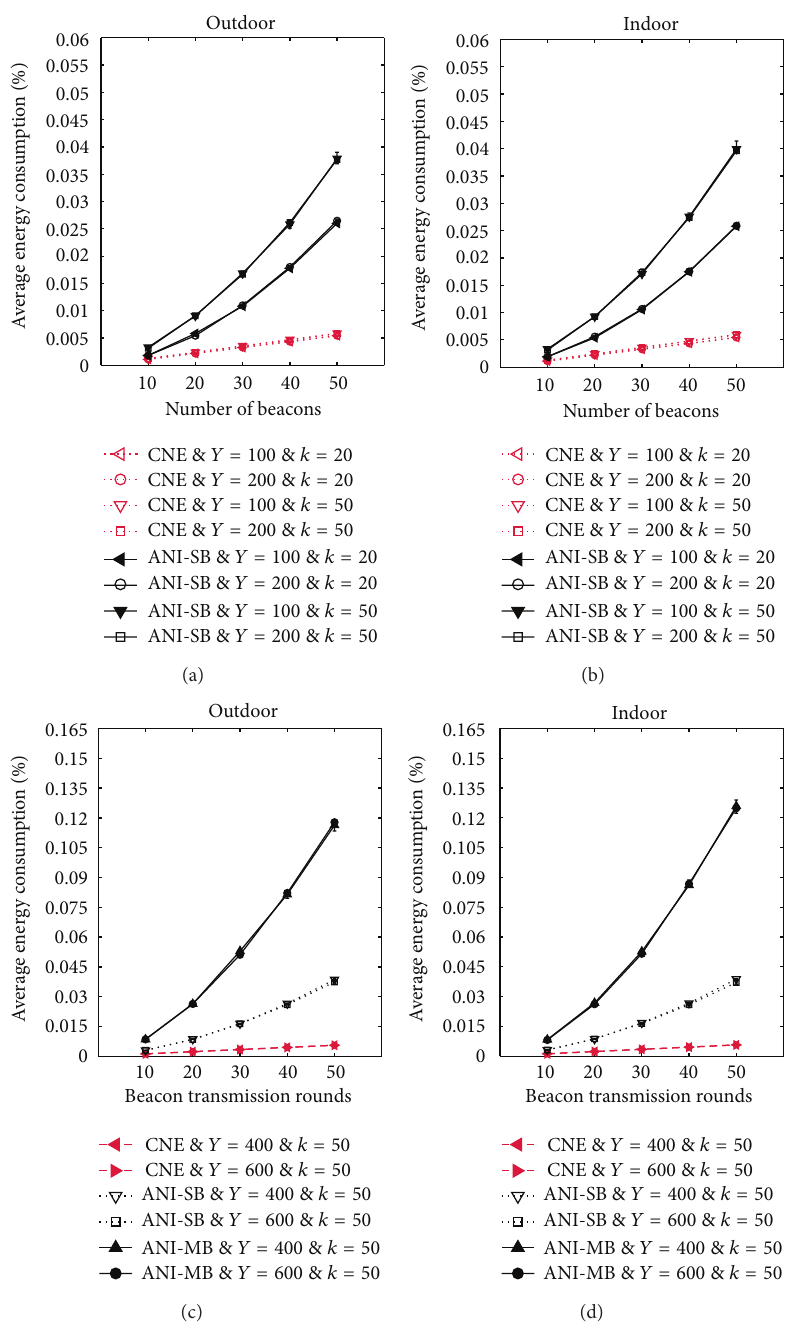
Figure 11: Overhead cost of running ANI-SB, ANI-MB, and CNE protocols in multihop topology networks deployed in outdoor and indoor